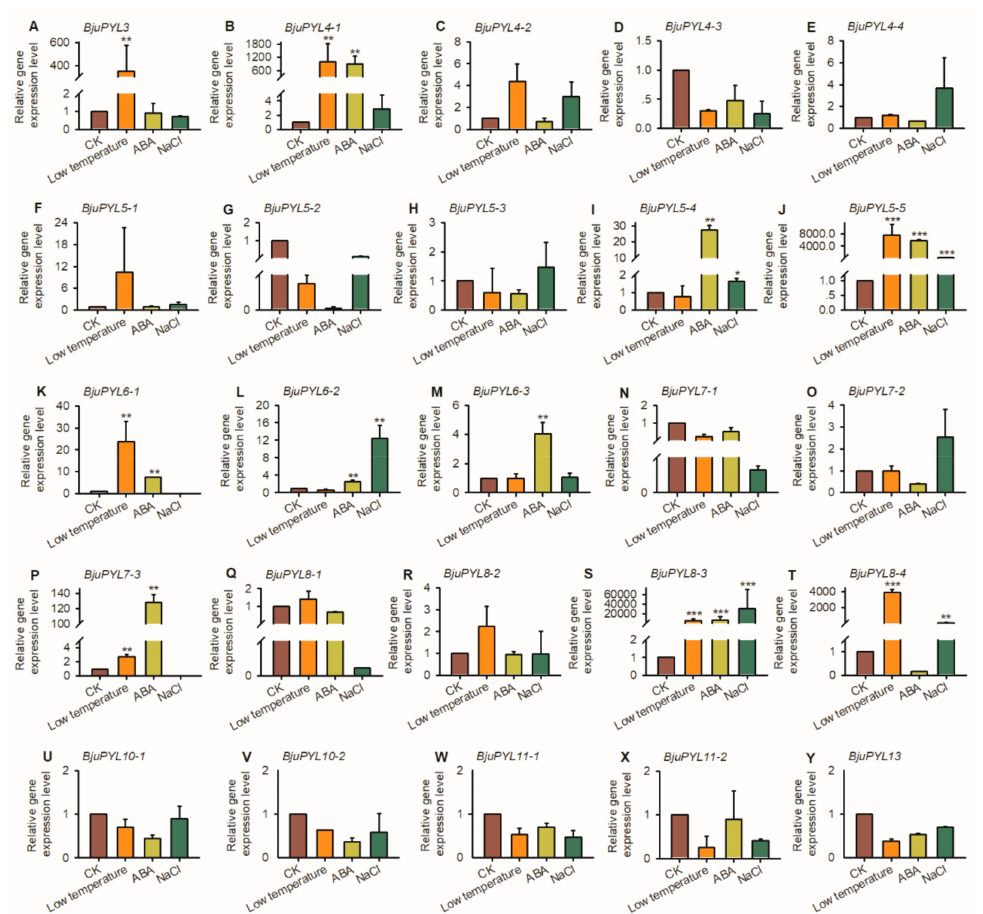
Figure 6. The expression patterns of BjuPYLs under abiotic stresses. Total RNA was extracted from 7-day-old seedlings treated with 200 mM NaCl, 50 µ M ABA, and at low-temperature (4 ◦ C) for 3 h. Data were normalized to the expression level of BjuActin3 . The values are means ± standard error. Three independent biological repeats were performed. CK: Control Check; ABA: Abscisic